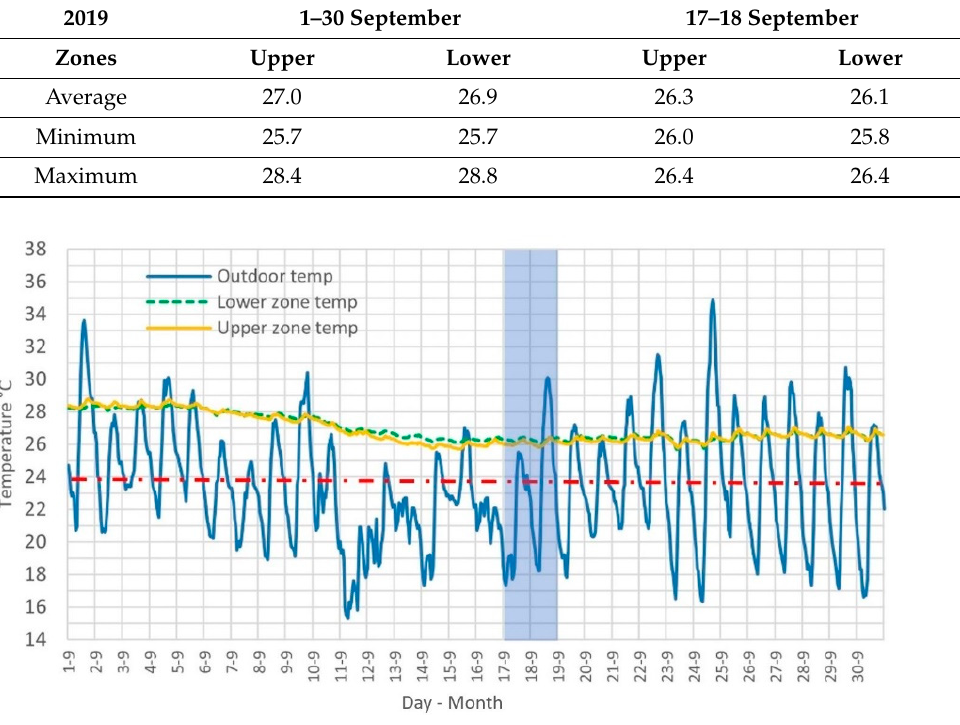
Figure 8. Air and surface temperature in Zone 1 for north orientation on 16/09/2019.